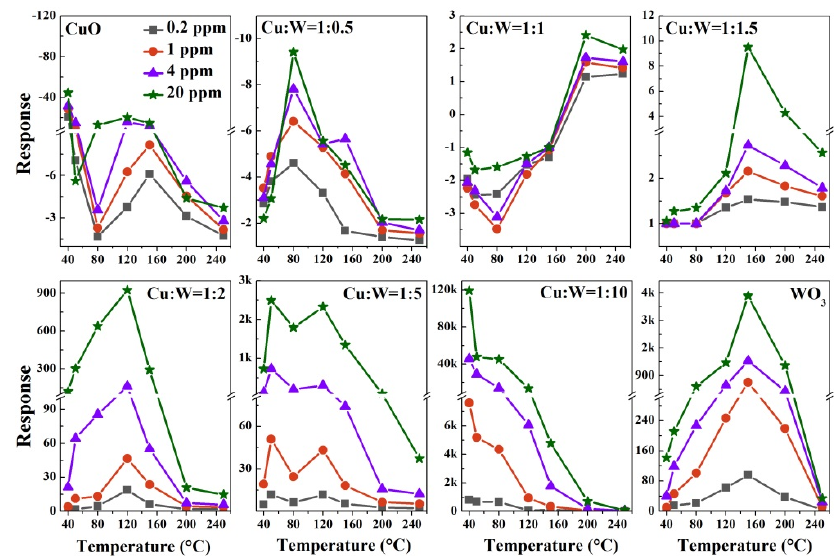
Figure 7. The responses of the CuO/WO 3 composites to H 2 S gas as a function of the operating temperature.